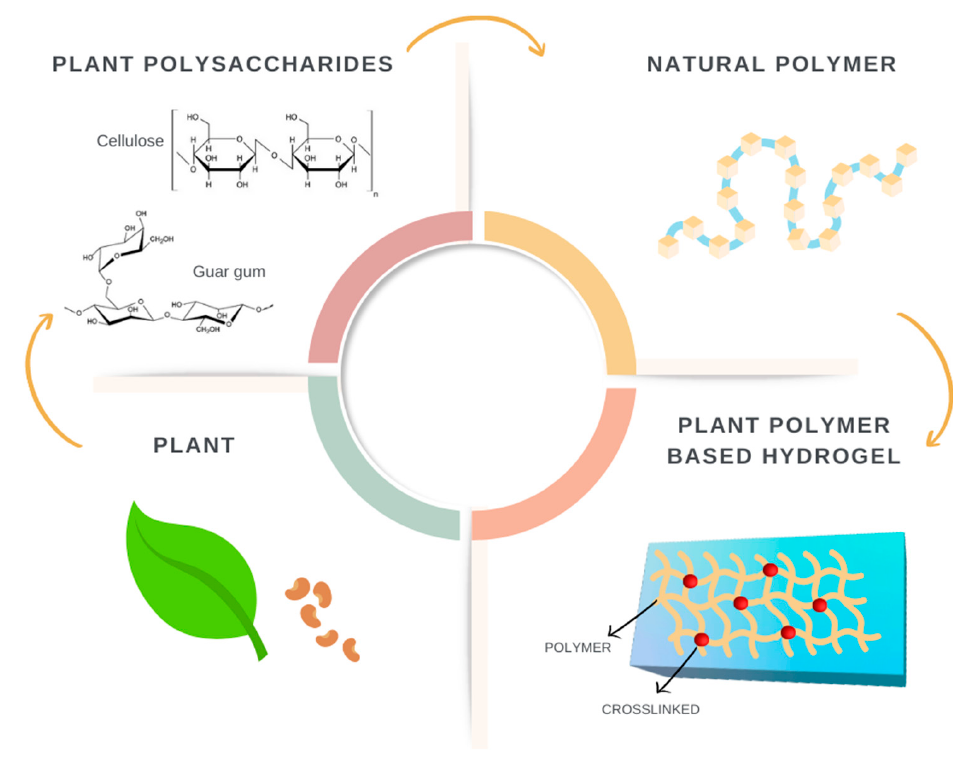
Figure 2. Plant-derived polymers used in hydrogels’ development.